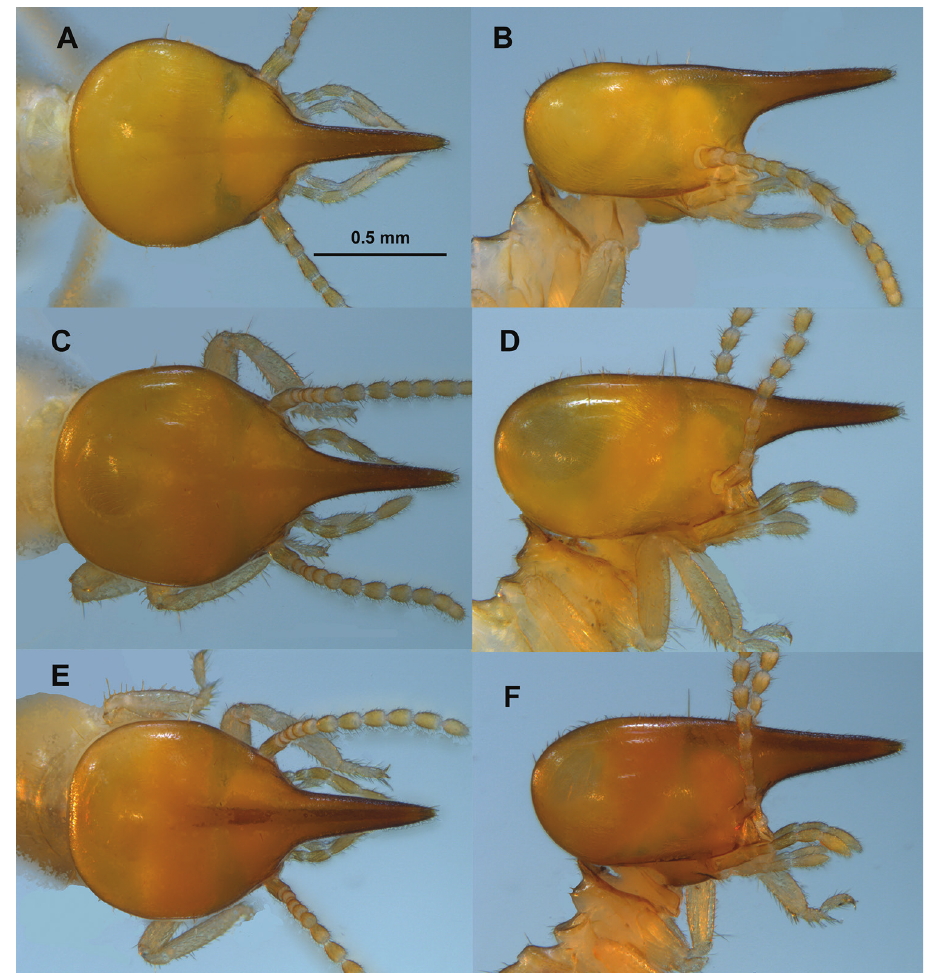
Figure 3. Parvitermes soldier head capsule. Parvitermes mexicanus comb. n., A dorsal B lateral. Parvit- ermes mesoamericanus sp. n. C dorsal D lateral. Parvitermes yucatanus sp. n. E dorsal F lateral.